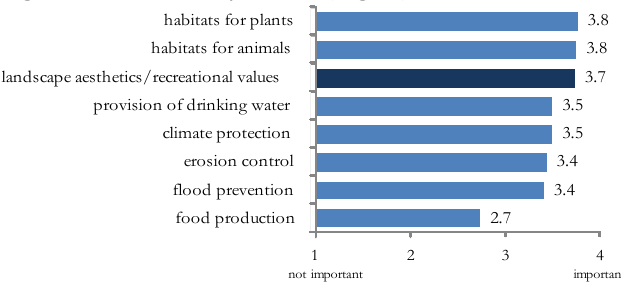
Fig. 6. The appreciation of various ecosystem services by visitors surveyed in the Eastern Ore Mountains (average values; large numbers values = high